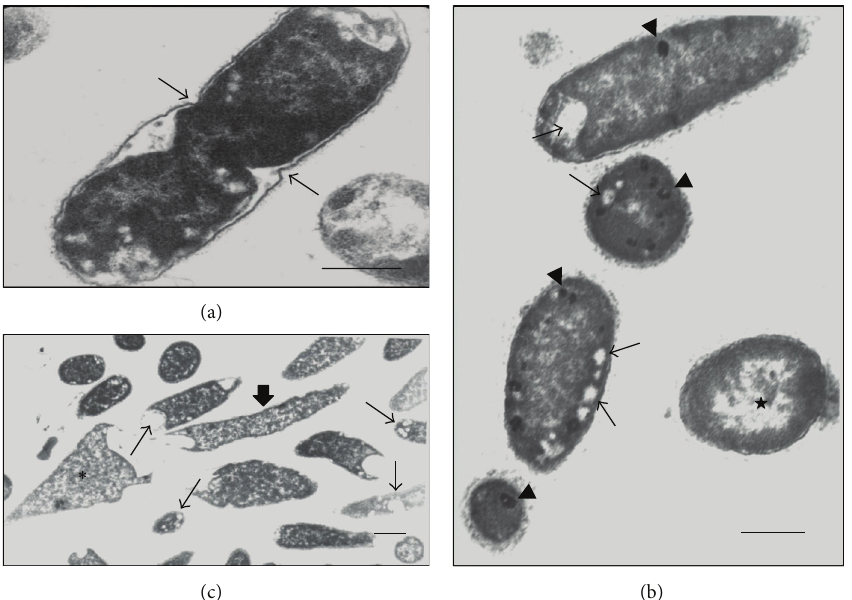
Figure 7: (a–c) Transmission electron micrographs of isolate K21.1-F and K58.1-F of K. pneumoniae . (a) Isolate K21.1-F submitted to 0.5 𝜇 g mL −1 ampicillin. Observe irregular formation of septa in a dividing cell (arrow). (b) Isolate K58.1-F subjected to 0.5 𝜇 g mL −1 of ampicillin. Cells present electron-lucent (fine arrow), and electron-dense spaces with different sizes and shape throughout the bacterial cytoplasm (arrowheads), in addition to reduction of cytoplasmic contents (star). (c) Isolate K58.1-F subjected to 4 𝜇 g mL −1 of amoxicillin. The cells exhibit altered morphologies with cell elongation (large arrow) and undefined forms (asterisk), with the presence of electron-lucent structures with shape and varying sizes scattered throughout the cell cytoplasm (fine arrow). Bars = 0.5 𝜇